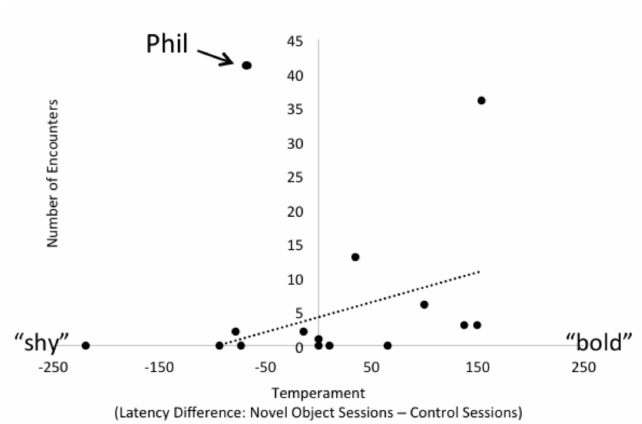
Figure 4. The relationship between temperament and participation in encounters. Penguins who scored higher on the shy-bold continuum tended to participate voluntarily in more encounters. The trend line shown here does not include Phil, a potential